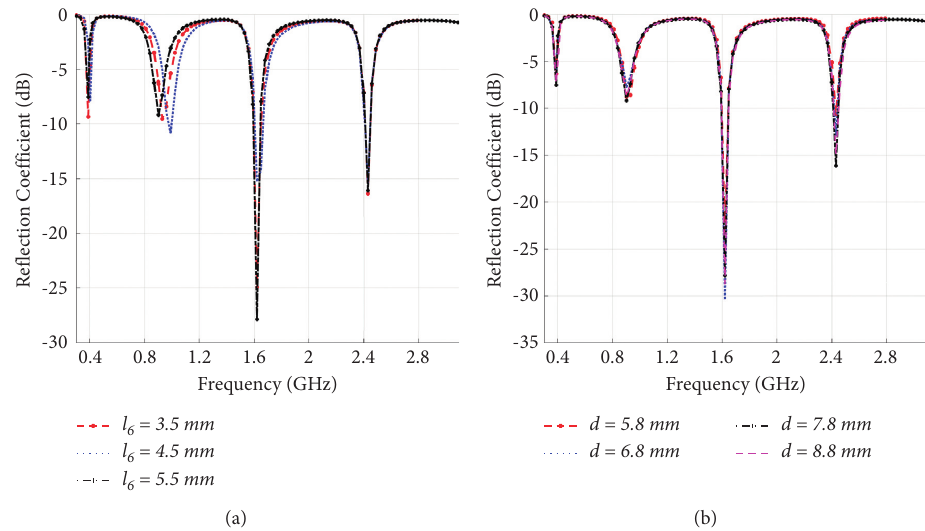
Figure 6: (a) Effect of increasing the length of l 6 , (b) varying the distance between the shorting strip and feeding probe ( d